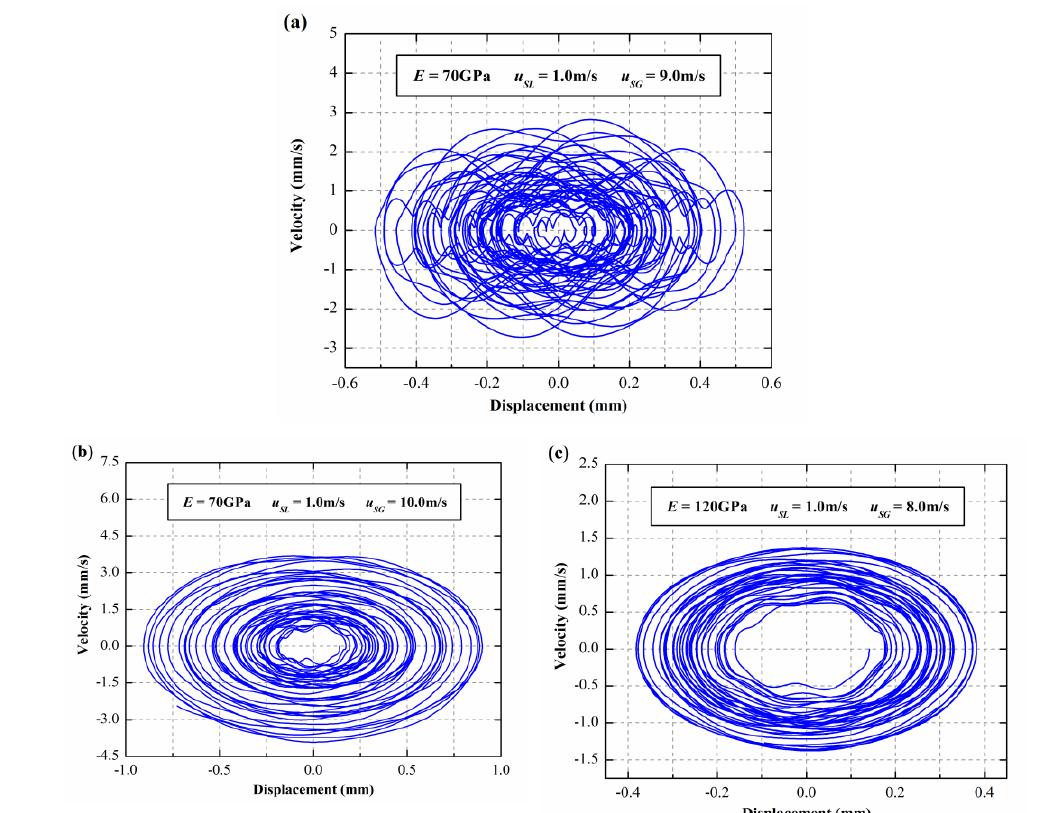
Figure 11. Phase portraits of several typical conditions (( a ): E =70GPa, u SL = 1.0 m/s, u SG = 9.0 m/s; ( b ): E =70GPa, u SL = 1.0 m/s, u SG = 10.0 m/s; ( c ): E =120GPa, u SL = 1.0 m/s, u SG = 8.0 m/s;).